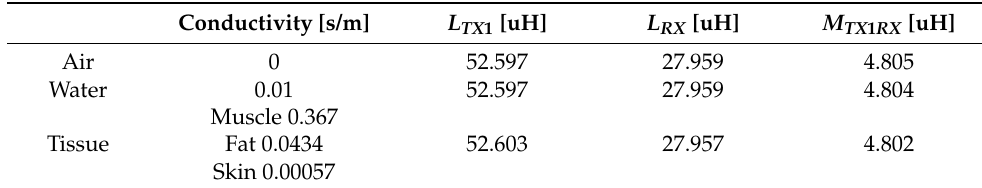
Table 3. Electrical parameters depending on the gap material.